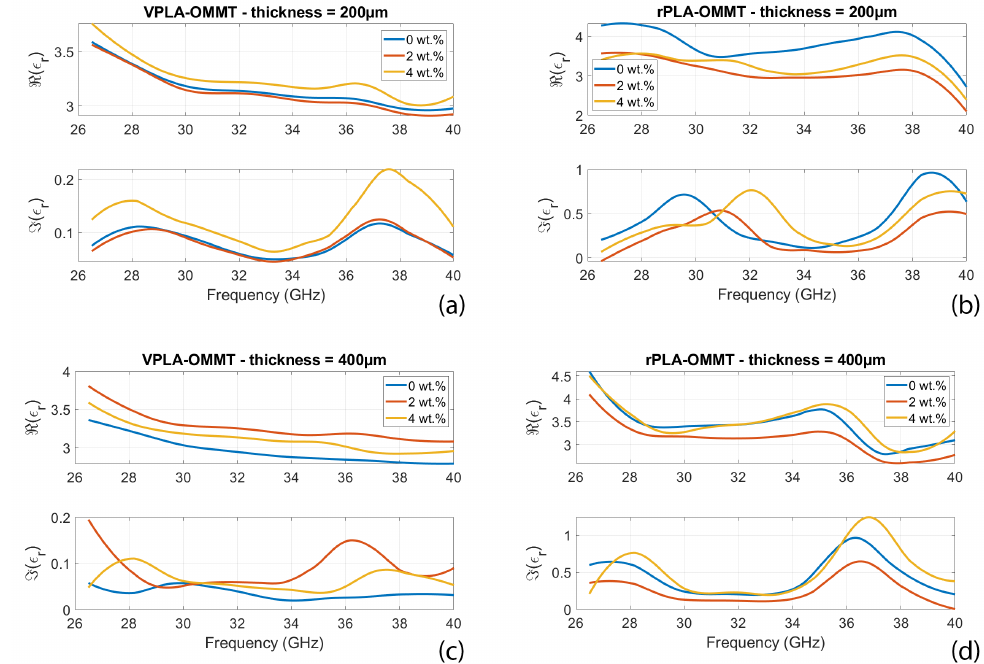
Figure 5. Real and imaginary parts of permittivity versus frequency and thickness of virgin and recycled PLA having various wt.% concentration in OMMT. ( a ) virgin PLA 200 µm-thick, ( b ) recycled PLA 200 µm-thick, ( c ) virgin PLA 400 µm-thick, and ( d ) recycled PLA 400